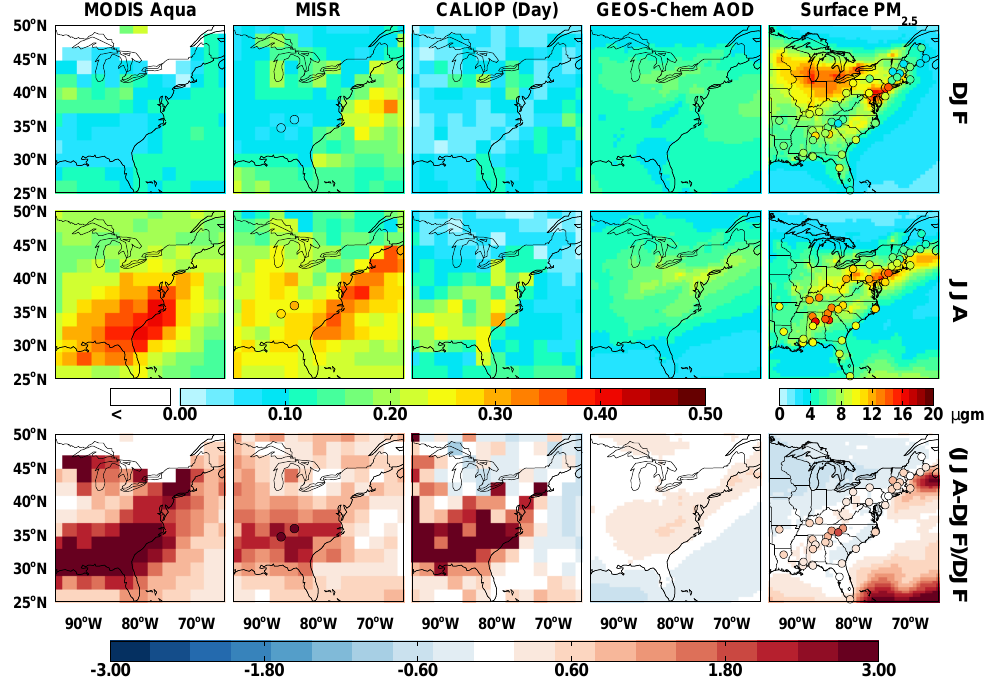
Fig. 1. Seasonally averaged total column AOD for winter (DJF, top row) and summer (JJA, middle row) for December 2006–August 2009 as observed by MODIS (column 1), MISR (column 2), and CALIOP (daytime, column 3) gridded to 2 ◦ × 2.5 ◦ and compared to simulated AOD from GEOS-Chem (column 4). Concentrations of surface PM 2 . 5 simulated by GEOS-Chem are overlaid with concentrations measured at IMPROVE and SEARCH network sites (circles) in column 5. Bottom row shows the relative enhancement of summer over winter for observed and simulated AOD and surface concentrations. Average AOD observed at the University of Alabama, Huntsville, and Walker Branch AERONET sites for 2008–2009 is overlaid (circles) on the MISR